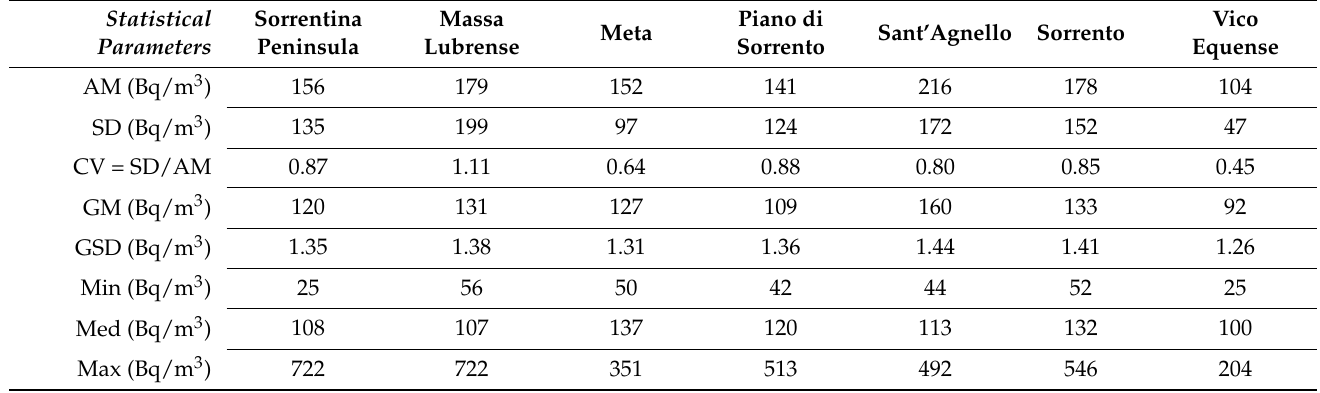
Table 1. Statistical parameters both for the total measurements on the Sorrentina peninsula and for each municipality before data normalization.